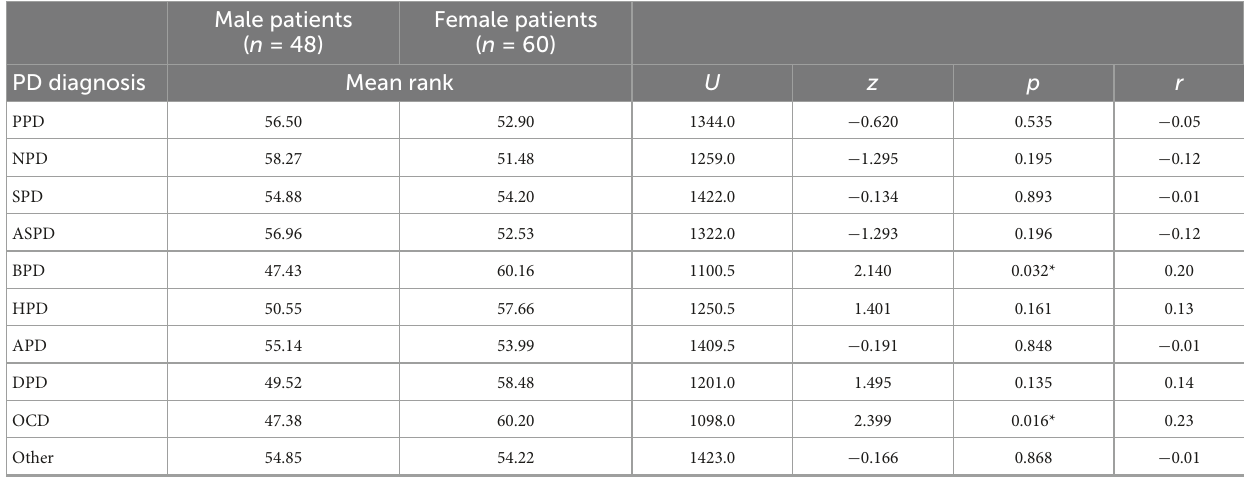
TABLE 6 Mann–Whitney comparisons for patient gender in vulnerable narcissism condition. Male patients Female patients ( n = 48) ( n = 60) PD